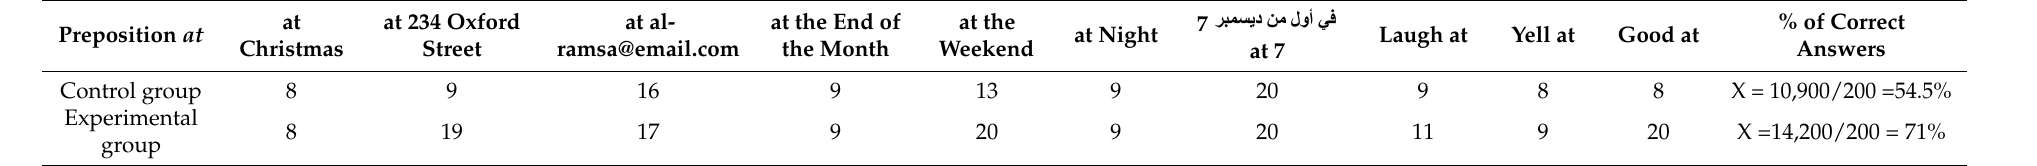
Table 12. Posttest 2 of the preposition at . Table 7. Posttest 1 for the preposition on .